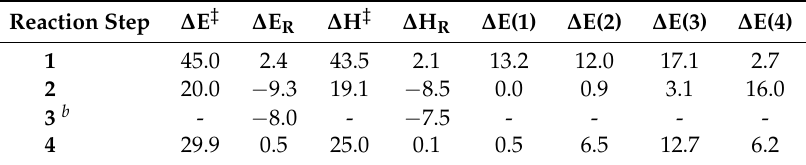
Table 1. Activation energy ∆ E ‡ , reaction energy ∆ E R , activation enthalpy ∆ H ‡ , and reaction enthalpy − catalyzed methanol carbonylation a . Energy values ∆ E ( m ) ∆ H R for each step of the [Rh(CO) 2 I 2 ] denote the energy consumed in phase m up to the TS. c Reaction Step ∆ E ‡ ∆ E R ∆ H ‡ ∆ H R 45.0 − 8.0 - 29.9 0.5 25.0 0.1 0.5 6.5 6.2 a B3LYP/6-31G(d,p)/SDD level of theory. All values (kcal/mol) are given relative to the first point in the entrance channel of the corresponding reaction step. b Downhill reaction without TS. c ∆ E ( m ) of phase m is the energy difference between the energy of phase m and energy of phase m-1 , ∆ E ( 4 ) is an energy